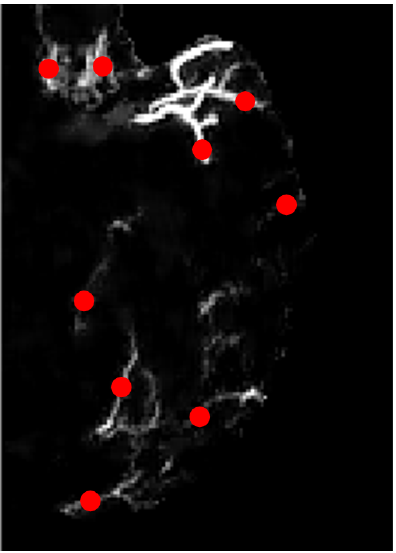
Figure 9. Zoomed-in image with marked locations in dotted